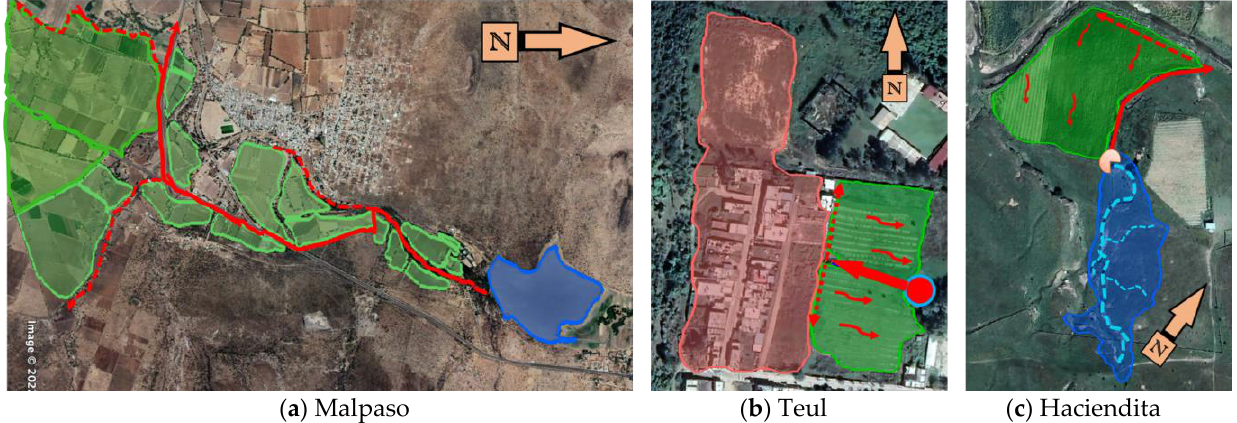
Figure 3. Agricultural systems irrigated by arched aqueducts (elaborated by authors with support from Google Earth © 2022).